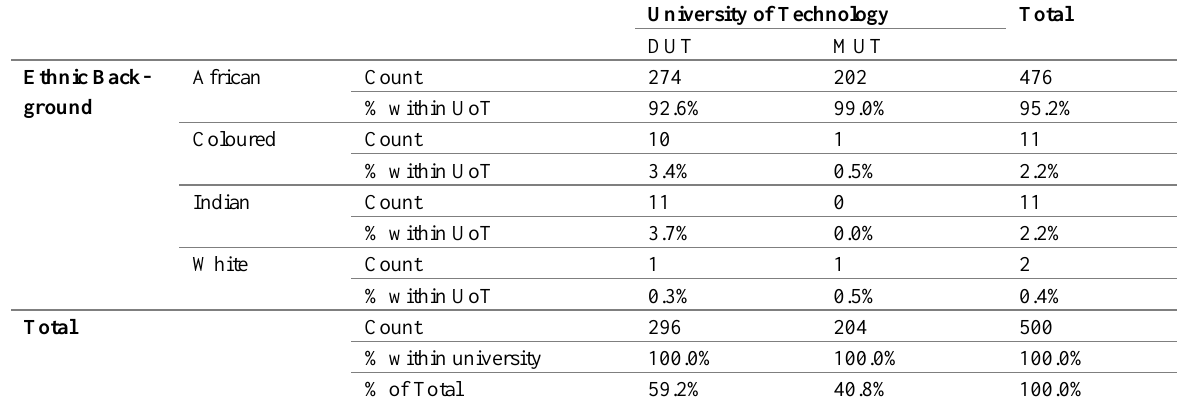
Table 4: Ethnicity by university